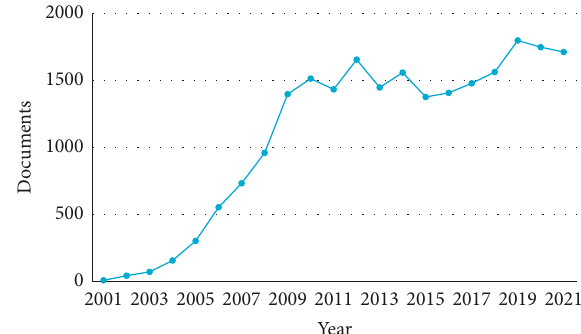
Figure 2: General publication trends on PSOA research (2001–2021).